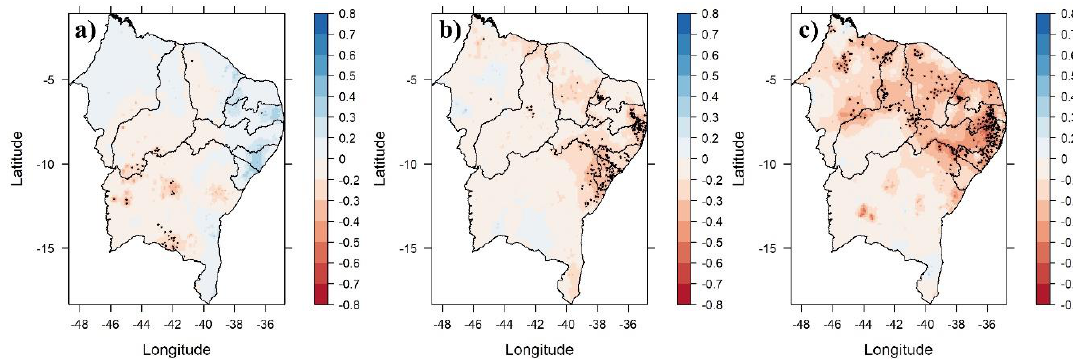
Figure 4. Trend of SPEI-3 / decade for the FMA quarter in quantiles ( a ) Q5, ( b ) Q50, and ( c ) Q95. The black points indicate municipalities whose series presented statistical significance.